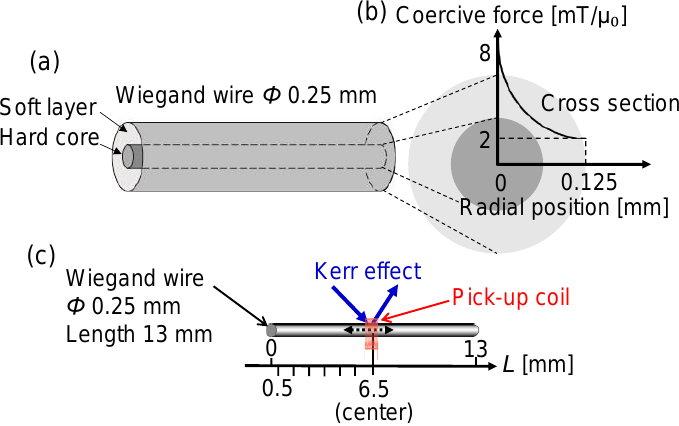
Figure 1. ( a ) Magnetic structure of a Wiegand wire and ( b ) distribution of the coercive force along the radial position of the wire. The outer layer and the inner core are assumed to have magnetically soft and hard properties, respectively; ( c ) setup of the magneto-optical Kerr effect (MOKE) and pick-up coil measurements for the Wiegand wire. The diameter and length of the wire are 0.25 mm and 13 mm, respectively.